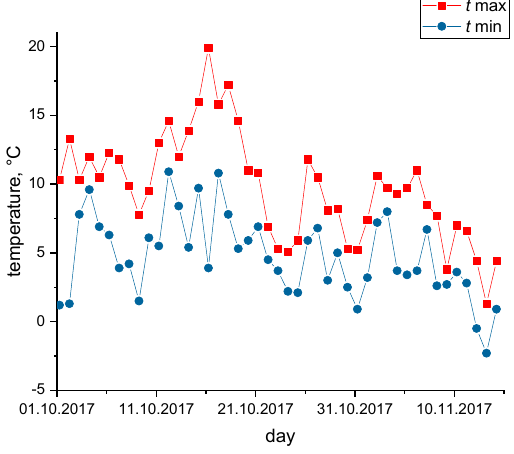
Figure 6. Precipitation for Bialystok station. Water 2019 , 11 , x FOR PEER REVIEW